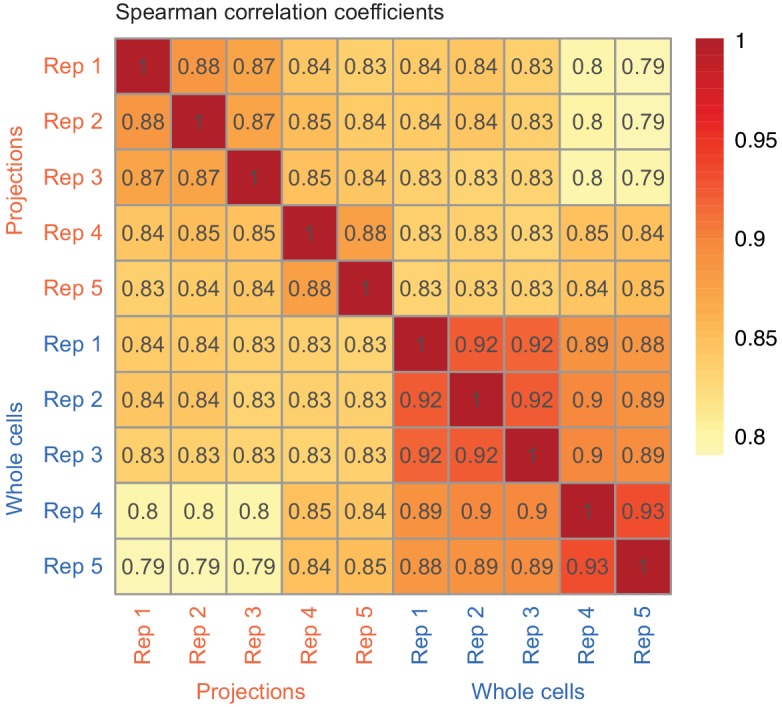
Correlation between RNAseq from biological replicates.Correlation between biological replicates (TPM values) of whole cell and projection RNAseq datasets. The color gradient corresponds to the value of Spearman’s correlation coefficient shown in each cell of the heatmap.